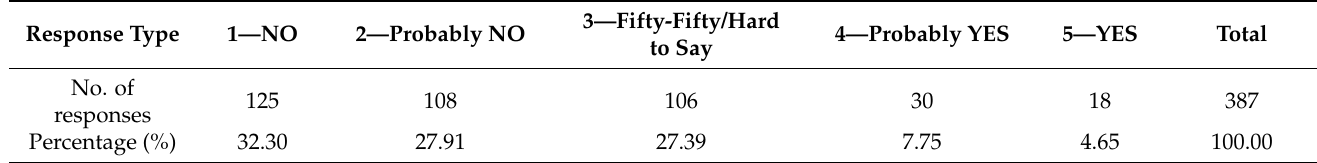
Table 2. Quantitative statistics for the first question: Would you be inclined to buy digital assets?